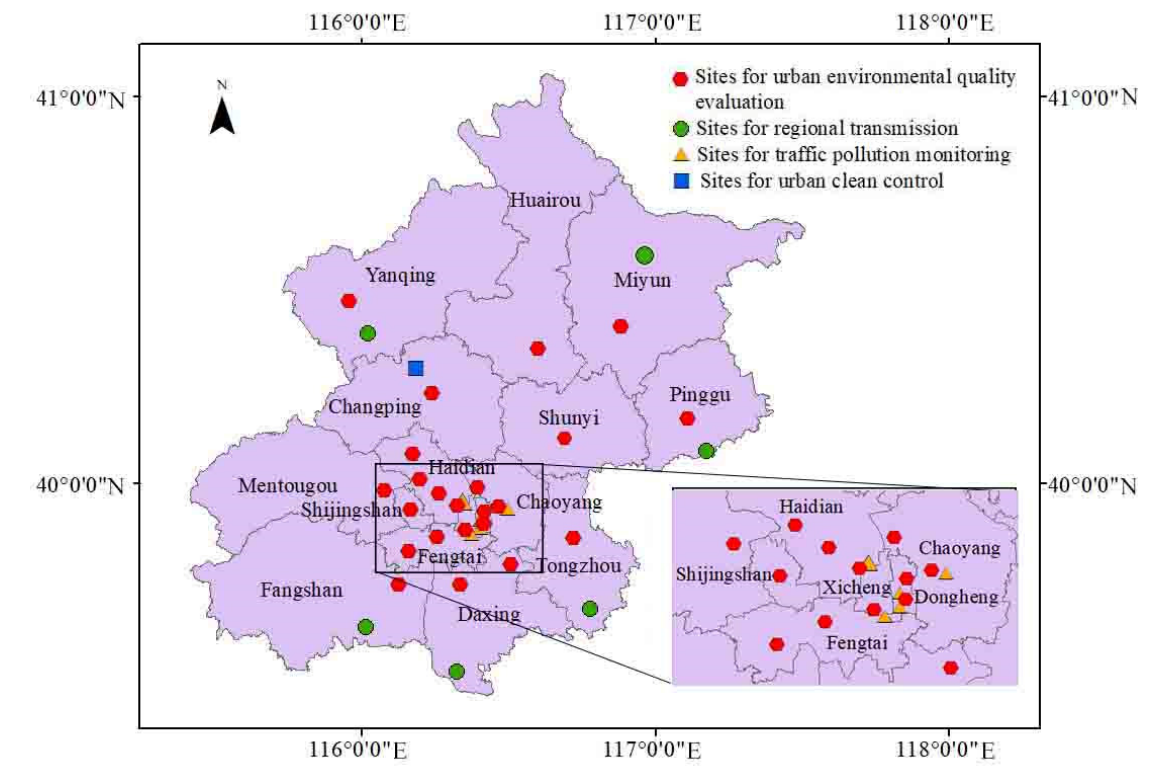
Figure 1. Map of the study area showing the location of the O 3 monitoring stations.